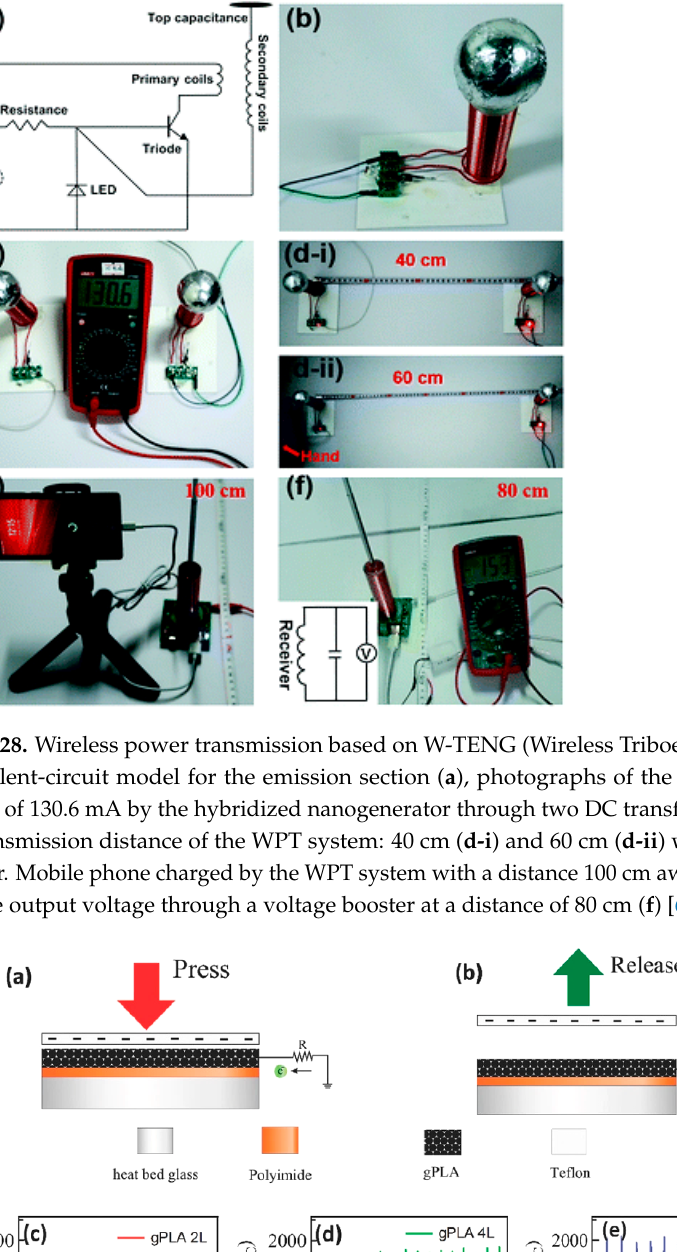
Figure 29. Cross-sectional view of the W-TENG and working mechanism’s schematic: pressure ( a ) and release ( b ) phases of the top electrode (Teflon); dependence of W-TENG’s output voltage on thickness of the gPLA bottom electrode; here 2L, 4L, 6L represent two, four, and six layers of printed gPLA electrodes whose thicknesses are ≈ 1, 2, 3 mm, respectively ( c – e )